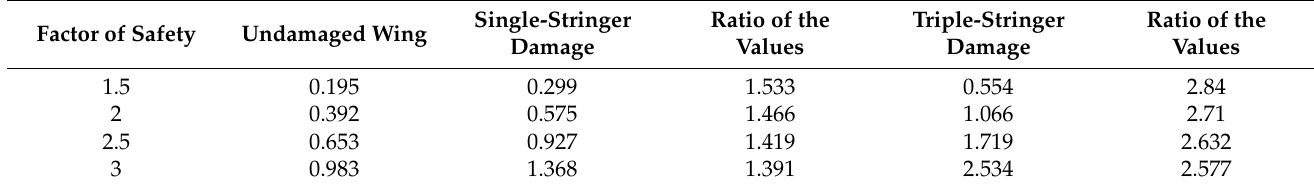
Table 13. Comparison of Hashin fiber tensile failure in the undamaged wing and wing containing stringer damage.